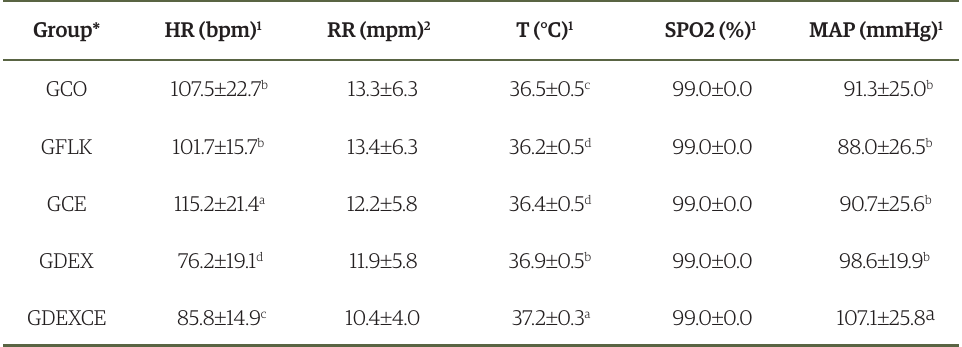
Table 1. Physiological parameters of animals undergoing ovariosalpingohisterectomy, analyzed in each group. Group* HR (bpm) 1 RR (mpm) 2 T (°C)